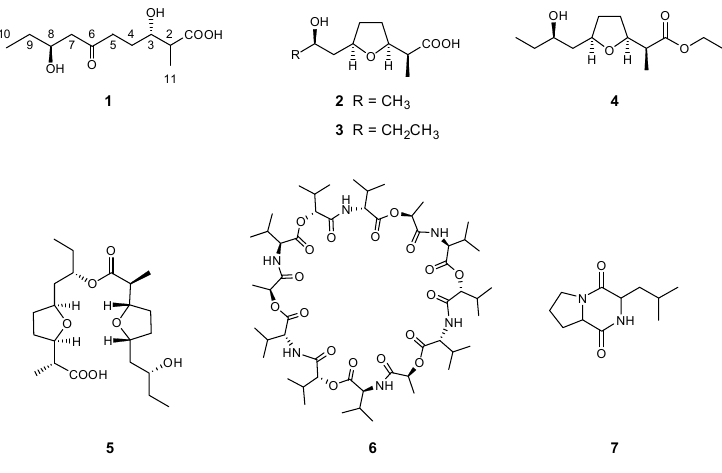
Figure 1. Structures of compounds 1 – 7 .